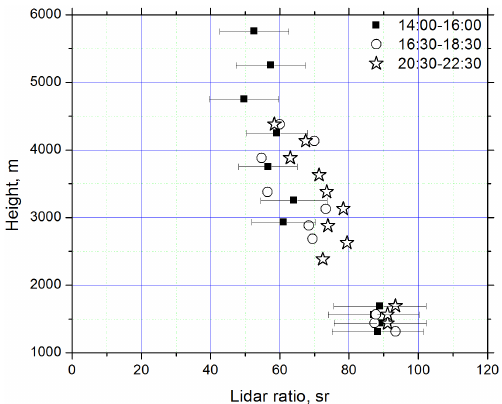
Figure 6. Lidar ratios at 355nm on 26 August averaged over the same time intervals as in Fig. 5.